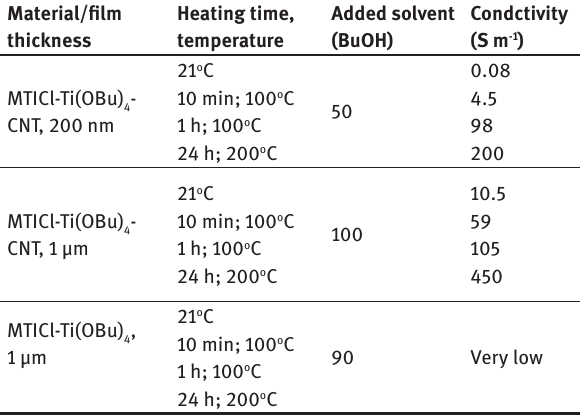
Figure 3: (a) Dispersed CNT ropes, MTICl-Ti(OBu) are separated; (c),(d) SEM images of MTICl-Ti(OBu) Table 1: Different parameters of experimental